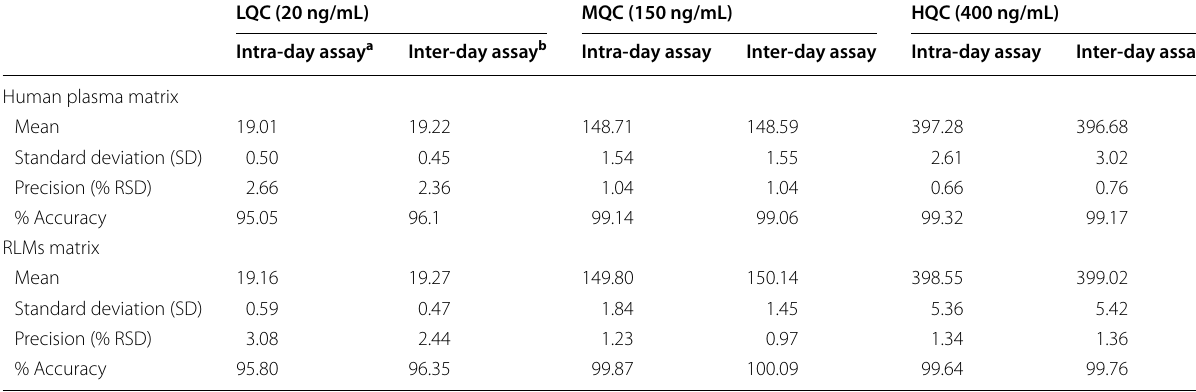
Table 2 Intra-day and inter-day precision and accuracy of the proposed methods